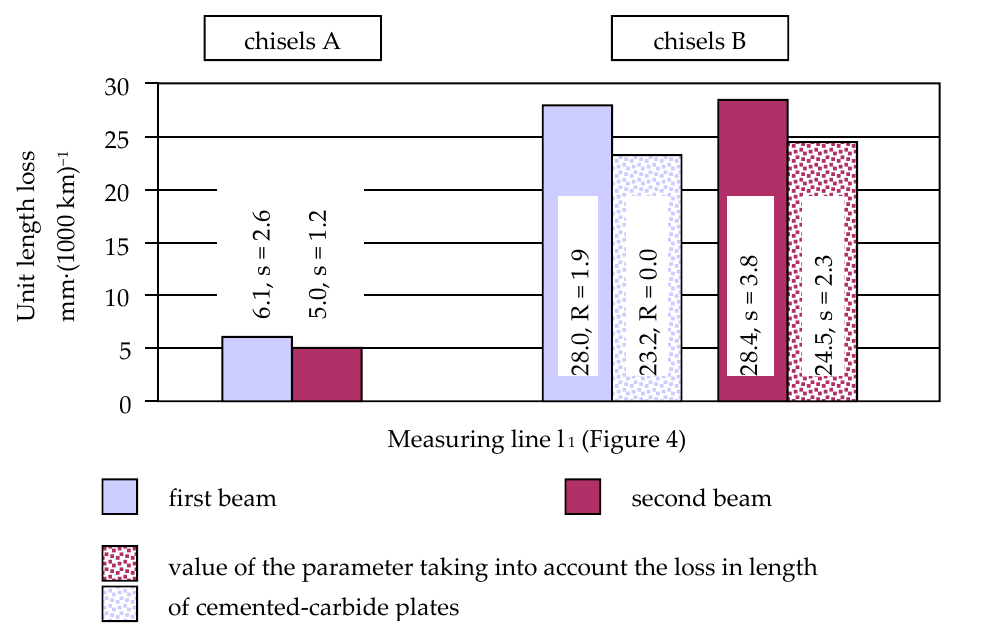
Figure 12. Unit length loss of chisels A and B (s, standard deviation; R, range). The unit length loss of chisels B, measured along the axis of the element (measurement In the range of measurement lines b 4 to b 9 , the value of the unit width loss of chisels line l 1 ), was comparable for the elements mounted on the first and second beams (Figure B successively decreased. This may indicate a lower soil load for the higher area of the tested elements.